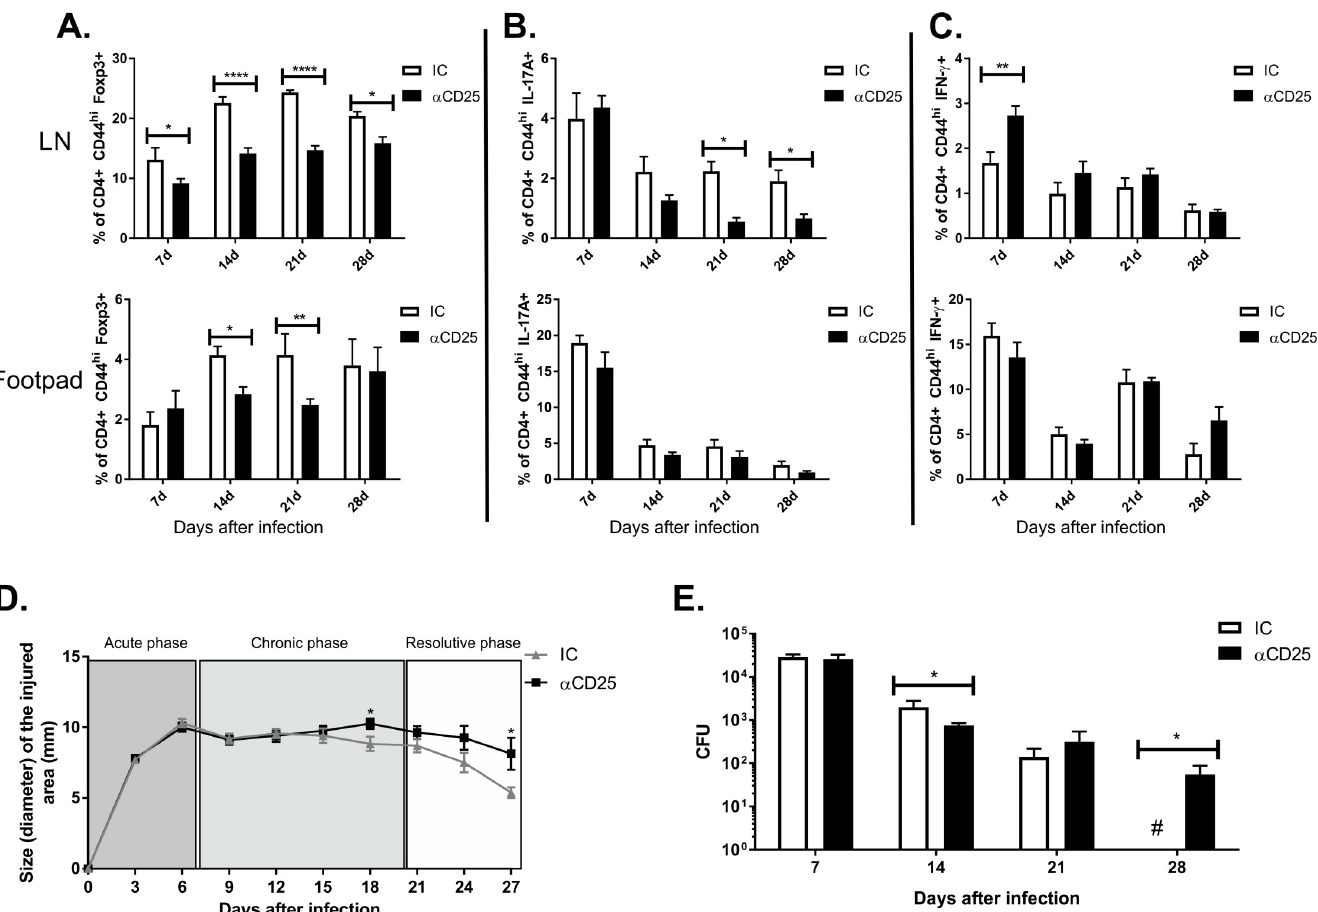
Fig 2. Reduction of Treg population is related to fungus persistence in infected tissue and opposes self-healing in murine experimental CBM. Low frequency of active CD4+ T lymphocytes expressing Foxp3 of animals treated with α -CD25 or control isotype (IC) is shown in popliteal lymph node and footpad ( A ). Frequency of IL-17+ T cells is decreased in dLN of animals treated with α CD25 after 21 and 28 days of infection ( B ). Frequency of IFN- γ + T cells increased after 7 days of infection in animals treated with α CD25 when compared to control mice ( C ). Morphometric analysis showed increased inflammatory aspect in those animals treated with anti- CD25, as indicated by footpad swelling measures ( D ). CFU quantification displayed a small increase in fungal load in those animals after 14 days of infection; however, fungal clearance was impaired after 28 days ( E ). � P < 0.05, �� P < 0.01, ��� P < 0.001 and ���� P <